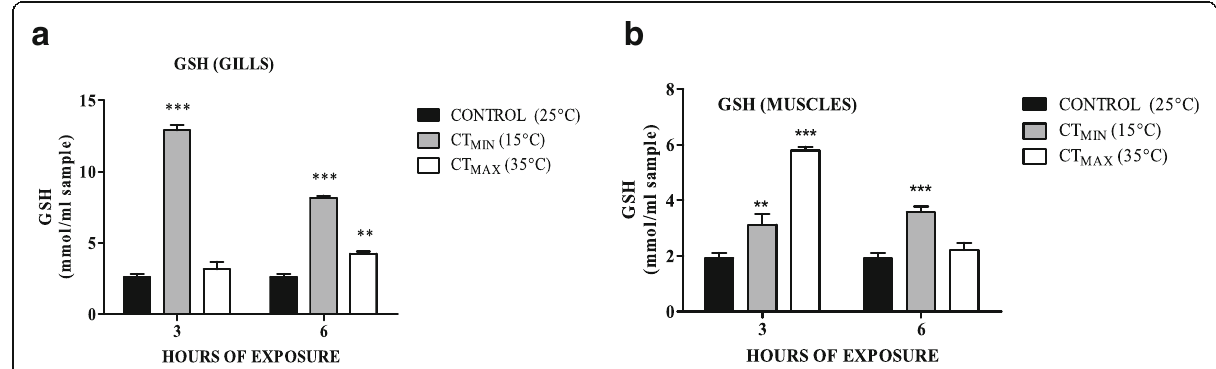
Fig. 4 Effect of temperature on the activity of GSH in the gills ( a ) and muscles ( b ) of Koi carps. Significance was calculated by two-way ANOVA followed by Bonferroni post-test where p < 0.001 (***); p < 0.01 (**). The vertical lines indicate mean ± SE. Bars represent different periods of exposure